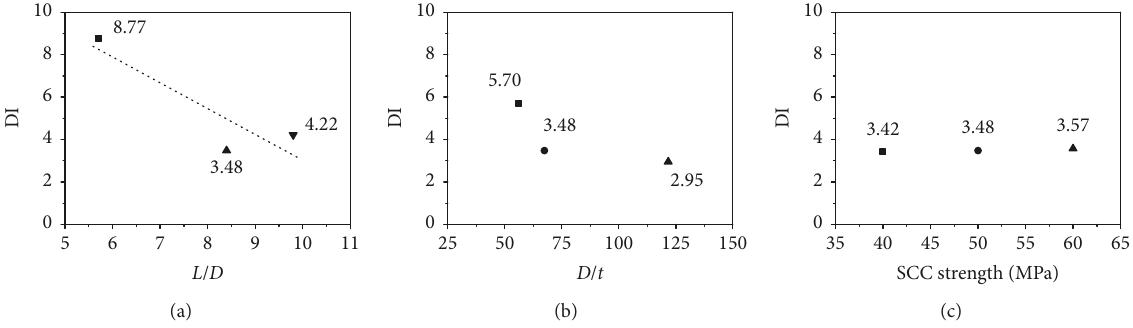
Figure 10: DI of specimens. (a) L / D ratio. (b) D / t ratio. (c) SCC